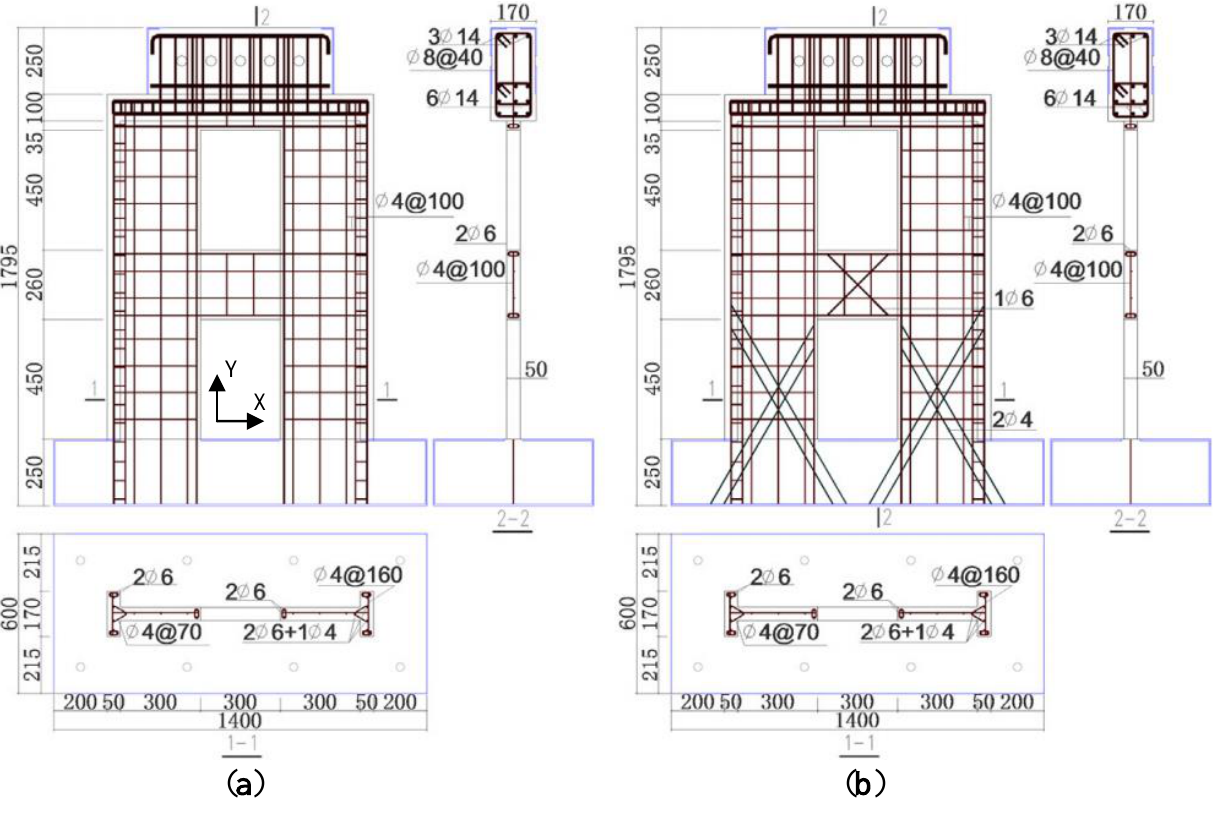
Figure 1. Dimensions and reinforcement of ( a ) A1; ( b ) A2 (unit: mm) [19]. Table 2. Mechanical properties of steel bars [19].